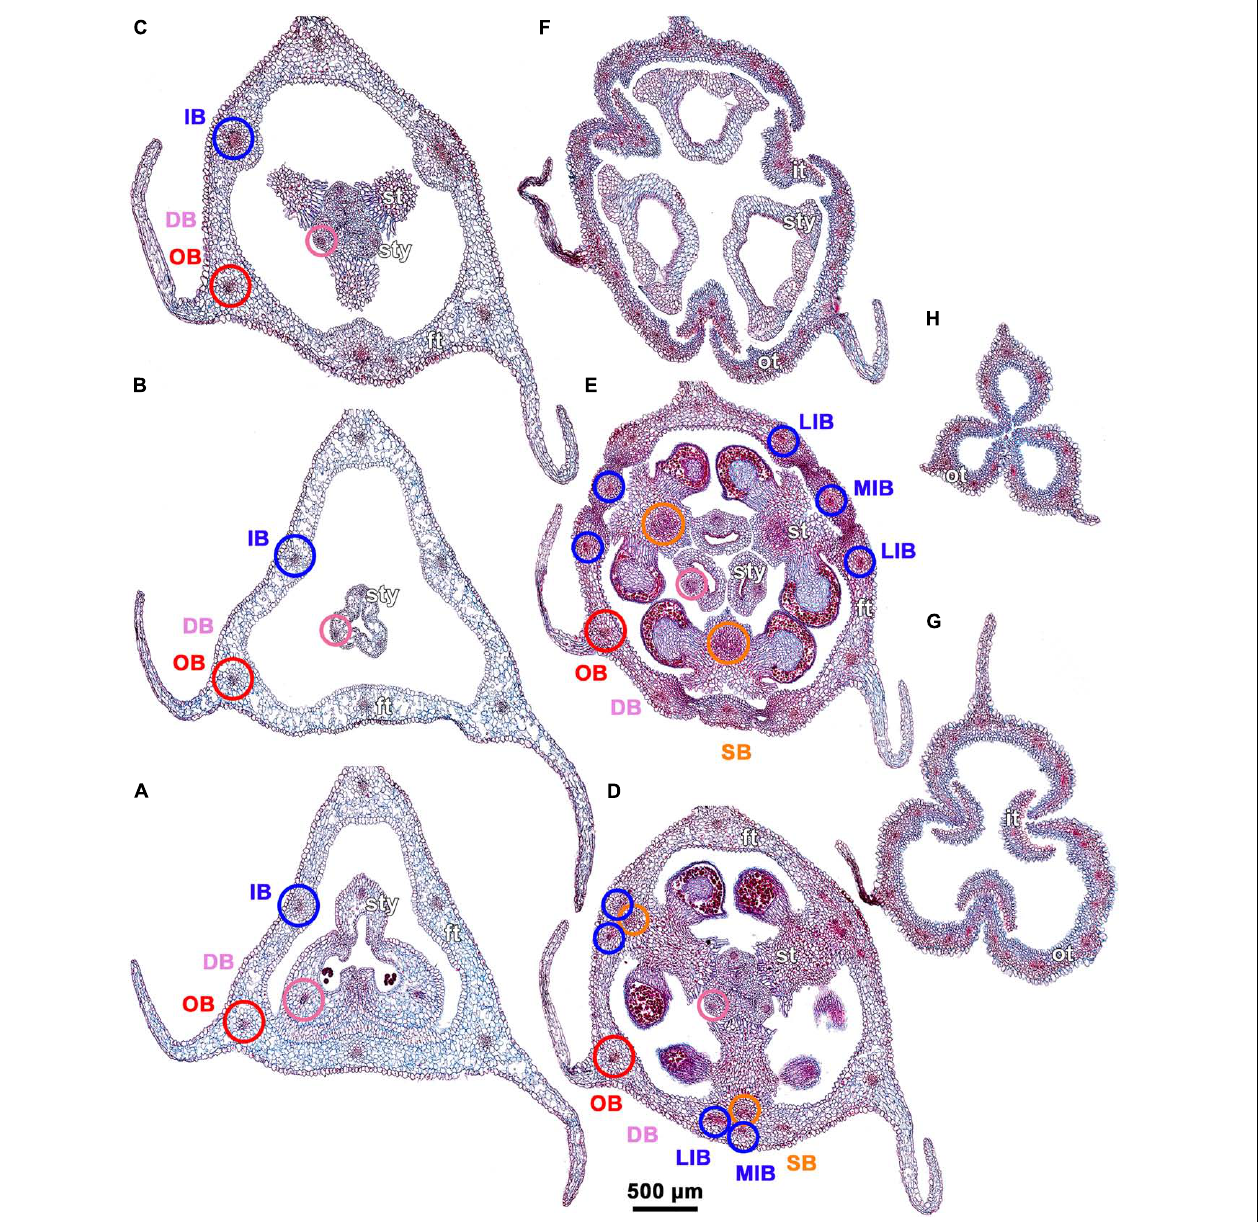
FIGURE 4 | Ascending series of transverse microtome sections of flower bud of Burmannia disticha (continued from Figure 3 ). (A) Flower at transition between ovary roof and common style. (B) Flower at level of common style. (C) Flower at level of basal spurs of anthers. (D) Flower at level of gynostegium. (E) Flower at level of anthers and style branches. (F) Flower at level of stigmas and perianth lobes. (G) Outer and inner tepal lobes. (H) Outer tepal lobes. ft, floral tube; it, inner tepal; ot, outer tepal; st, stamen; sty, style; DB, dorsal bundle; IB, inner bundle; LIB, lateral inner bundle; MIB, median inner bundle; OB, outer bundle; SB, stamen